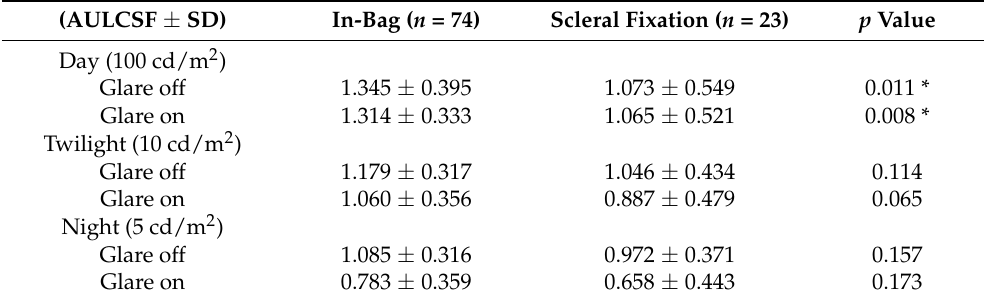
Table 3. Postoperative contrast sensitivity of eyes following in-bag and scleral-fixated intraocular lens implantation.